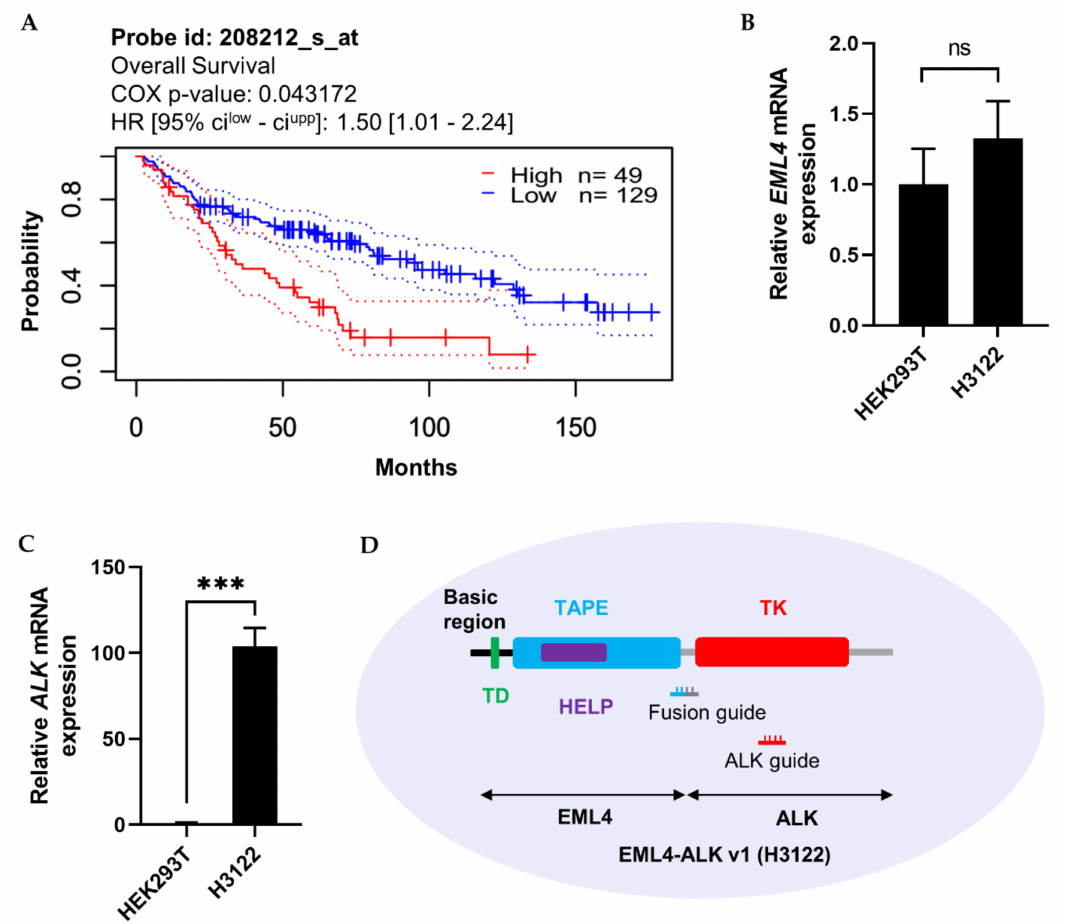
Figure 5. Clinical importance of ALK expression in lung adenocarcinoma, and EML4 and ALK mRNA expression in HEK293T and H3122 cells. ( A ) Kaplan–Meier analysis of patient survival in lung adenocarcinoma. Data were retrieved from the PrognoScan cancer microarray database, with COX p -value < 0.05. The prognostic curve di ff erentiates lung adenocarcinoma patients with high (red) and low (blue) ALK expression. The dotted lines indicate the maximum and minimum values of the survival average. ( B , C ) mRNA levels (assessed by qRT-PCR) of EML4 and ALK in HEK293T and H3122 cells. GAPDH was used as an internal control gene. ( D ) Graphical representation of EML4-ALK v1 oncofusion with the associated functional domain and guide RNA location in H3122 cells. Left side: TD, trimerisation domain; TAPE, tandem atypical propeller domain; HELP, hydrophobic motif in EML proteins; and TK, tyrosine kinase domain. Fusion guide, EML4-ALK target guide at the fusion point of EML4 and ALK ; ALK guide, EML4-ALK target guide in the TK domain. qRT-PCR results represent three biological replicates and two technical replicates. Statistical significance was determined by Student’s t -test. *** p < 0.001. ns, not